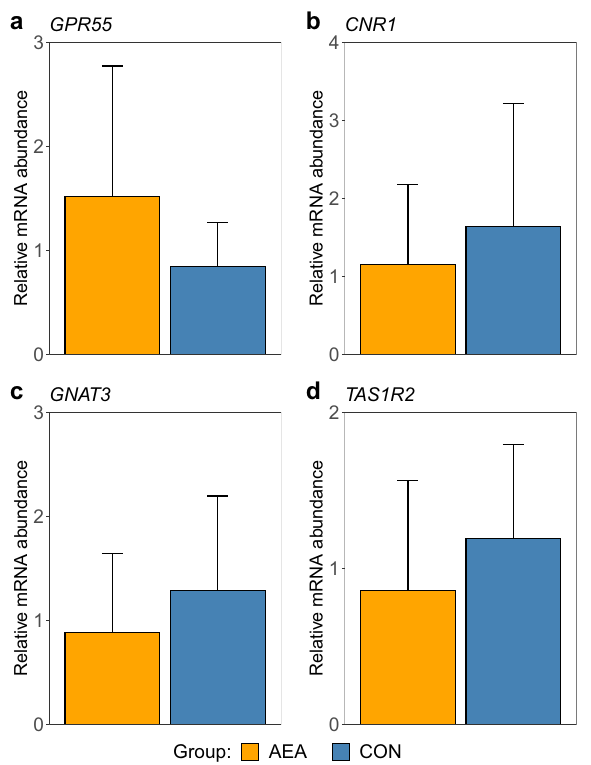
Figure 3. Relative mRNA abundance of ( a ) G protein-coupled receptor 55 ( GPR55 ), ( b ) cannabinoid receptor 1 ( CNR1 ), ( c ) G protein subunit alpha transducin 3 ( GNAT3 ) and ( d ) taste receptor type 1 member 2 ( TAS1R2 ) in tongue epithelia of cows treated intraperitoneally with NaCl (CON, n = 8) or N -arachidonoylethanolamide (AEA, n = 8). The mean of the observed data ± SD is shown for